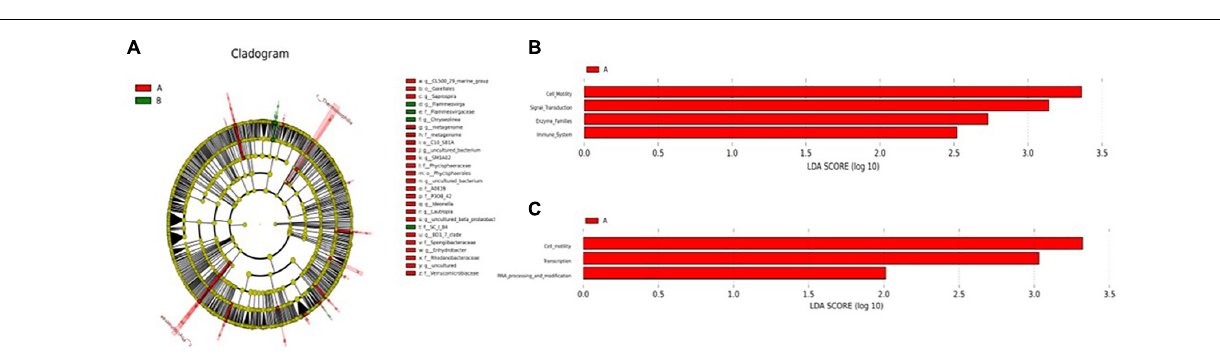
taxonomic unit (OTU) samples ranged from 1,367 to